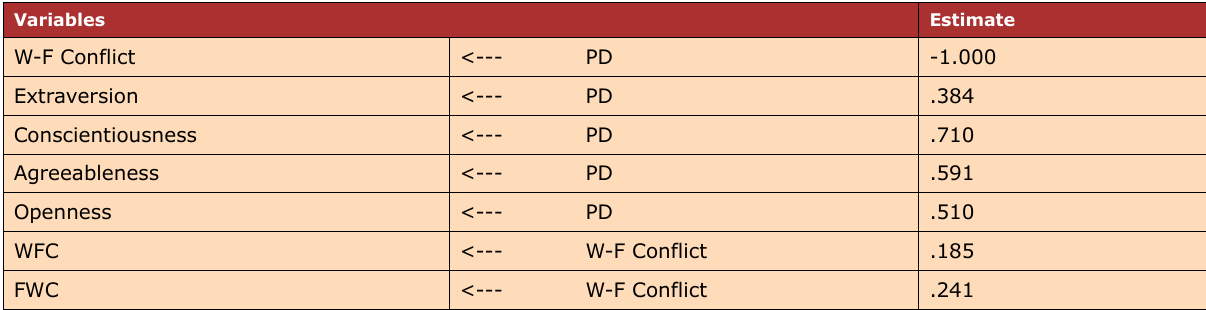
Table 3. Showing the Standardized Regression